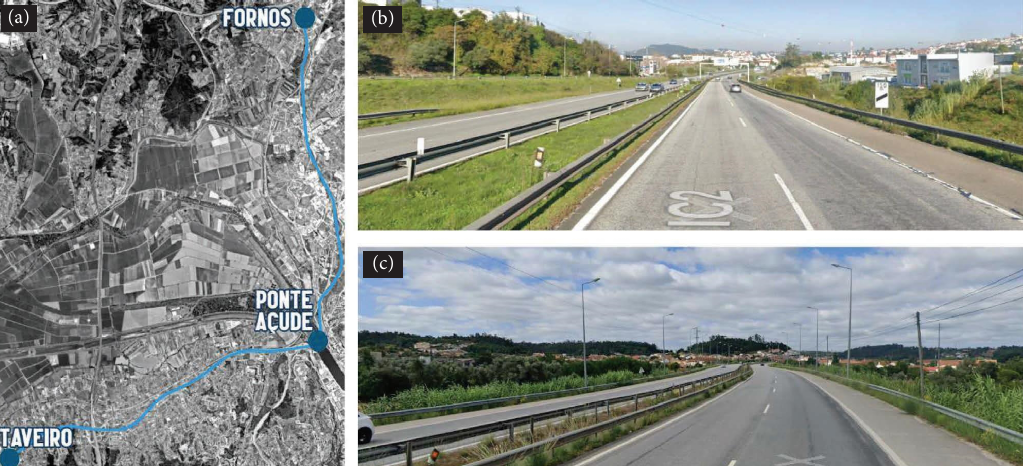
Figure 3: Experiment route in the city of Coimbra, Portugal: (a) circuit map; (b) IC2 freeway; and (c) via R´apida de Taveiro; (screenshots from Google Maps).